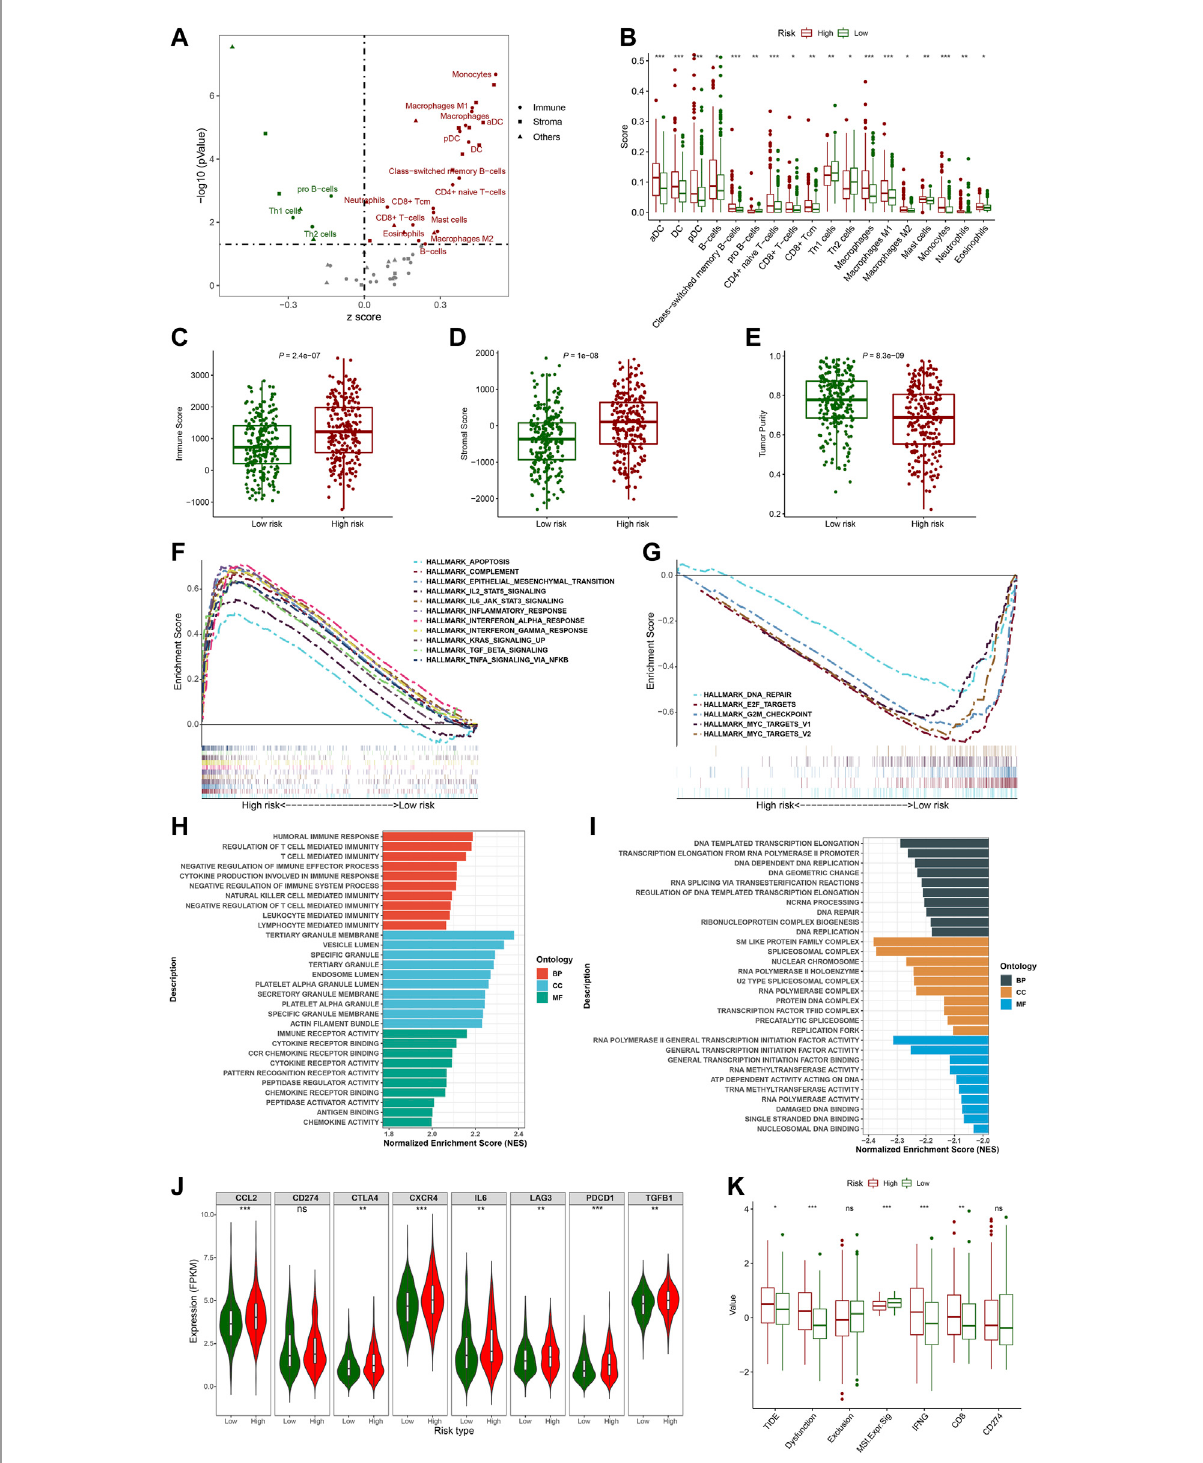
FIGURE 7 Evaluation of the tumor immune microenvironment based on the ferroptosis-related lncRNAs signature strati fi cation; (A) The volcano plot depicted the different cellular landscapes of the tumor based on the ferroptosis-related lncRNAs signature (FerRLSig) strati fi cation by the xCell analysis,thein fi ltrationofgreendotcellsweresigni fi cantlyhigherwhilereddotcellsweresigni fi cantlylowerinlow-riskgroupcomparedtohigh-risk group. (B) The boxplots depicted the signi fi cantly different in fi ltration of immune cell based on the FerRLSig strati fi cation. (C – E) The boxplots compared theimmunescores (C) , stromalscores (D) and tumor purity (E) based on the FerRLSig strati fi cation bythe ESTIMATE analysis. (F – G) GSEA